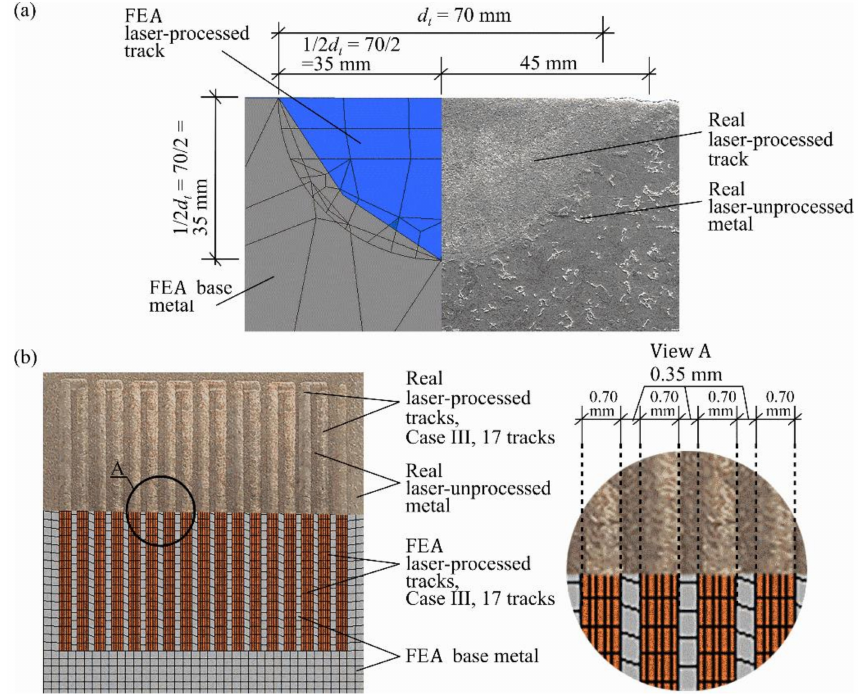
Figure 4. Cross-sections of a laser-processed track and the base metal of a FEA and a real specimen respectively ( a ) and the general view of the laser-processed tracks of case III of the real specimen and its FEA model respectively ( b